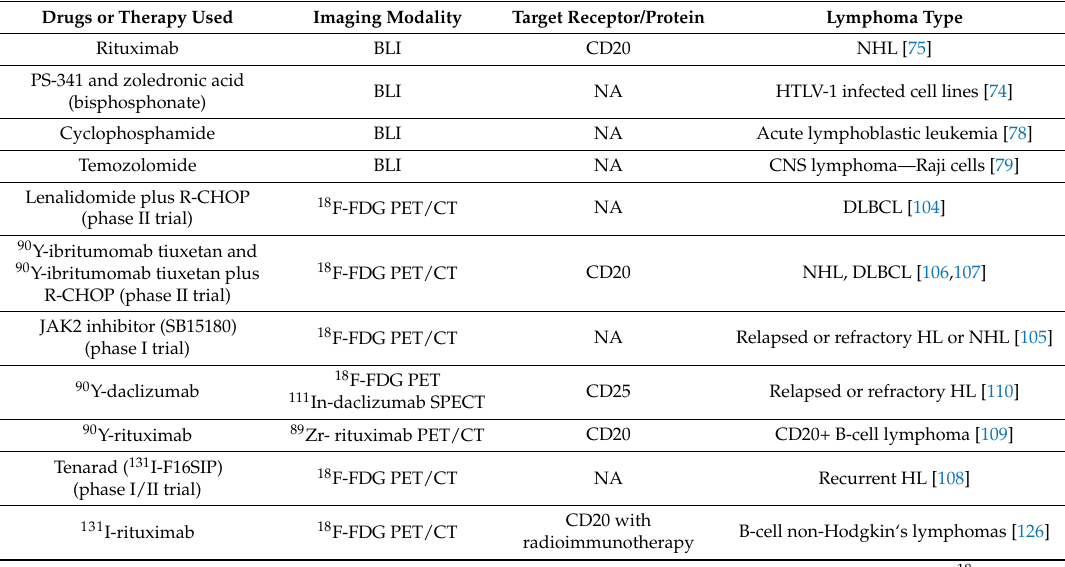
Table 2. Drug discovery and therapy for lymphoma via molecular